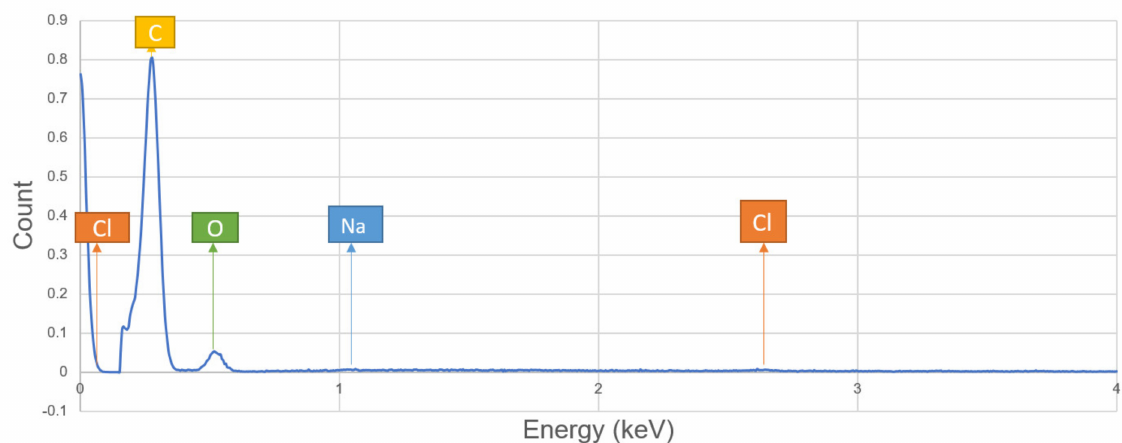
Figure 13. Spectrum analysis of the chemical structure of single sisal fiber hybrid composite surface position obtained at an intensity of 4 keV.